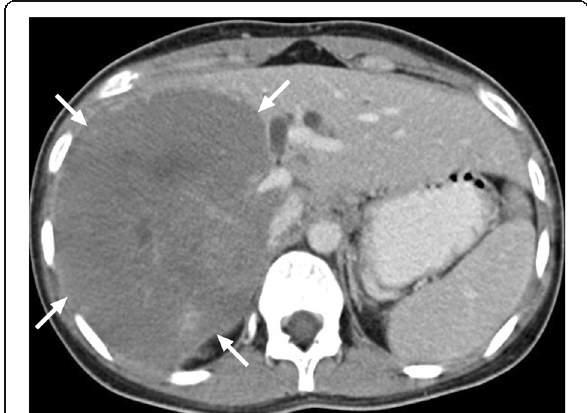
Fig. 6 A 33-year-old female with no known past medical history presented with gradually increasing right upper quadrant pain. Abdominal postcontrast CT demonstrates a hypoattenuating centrally necrotic massive mass lesion (arrows). There was no evidence of obvious enhancement after contrast injection. Percutaneous biopsy revealed alveolar hydatid cyst